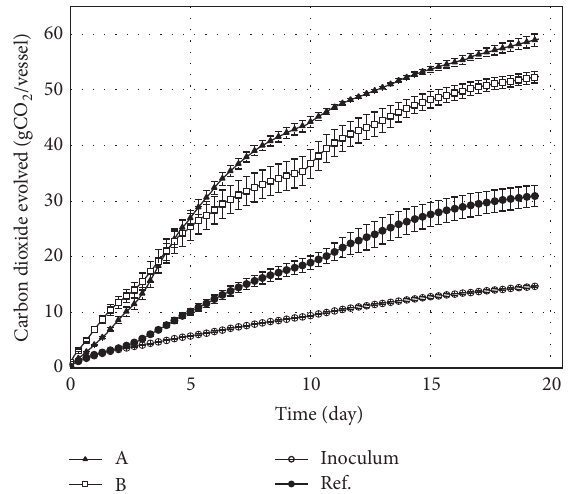
Figure 4: First biodegradation trial: cumulated CO 2 emissions per vessel. (A, B) PCL composites; (Ref) reference, cellulose. Error bars refer to standard error ( 𝑛 = 3 ).